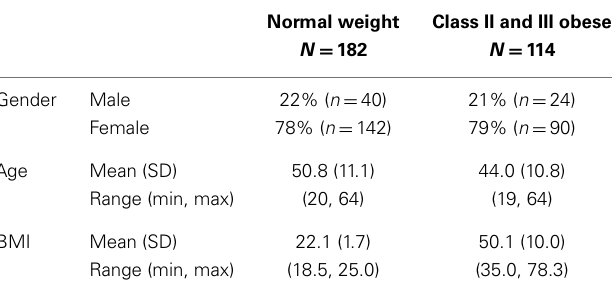
Table 2 | Description of the normal weight and obese study populations